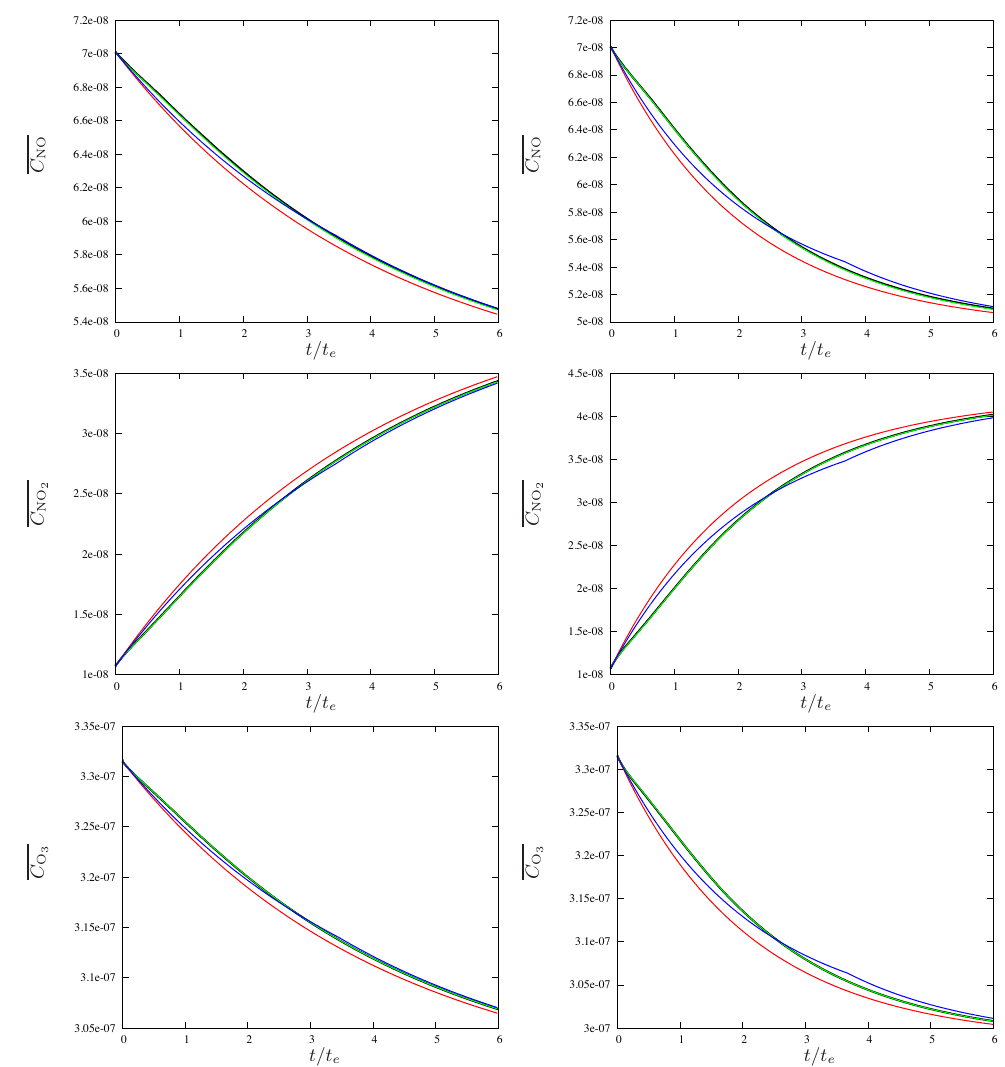
Figure 5. Evolution of computed and predictedcgrid-averaged species concentrations forcrun N1 Fig. 5. Evolution of computed and predicted grid-averaged species concentrations for run N1 (left panels, Da 2 = 4 . 2 ) and N2 (right panels, (left panels, Da 2 = 4.2) and N2 (right panels, Da 2 = Da 2 = 8 . 4 ).